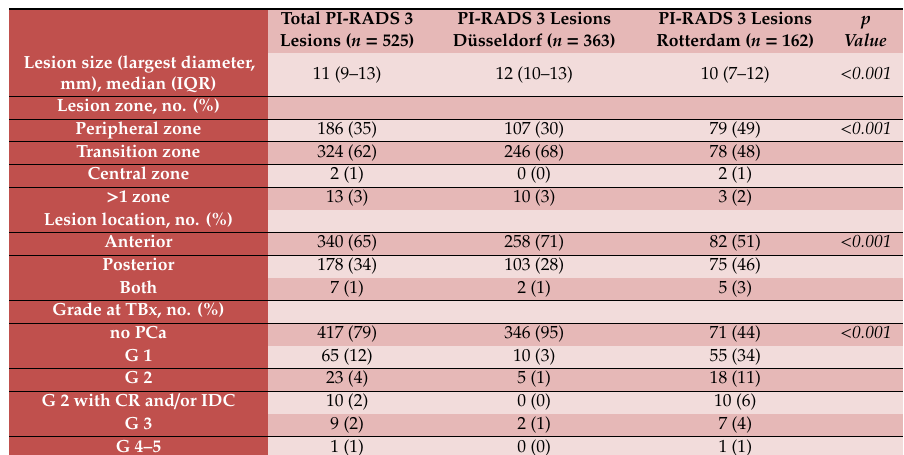
Table 2. PI-RADS 3 lesion characteristics.